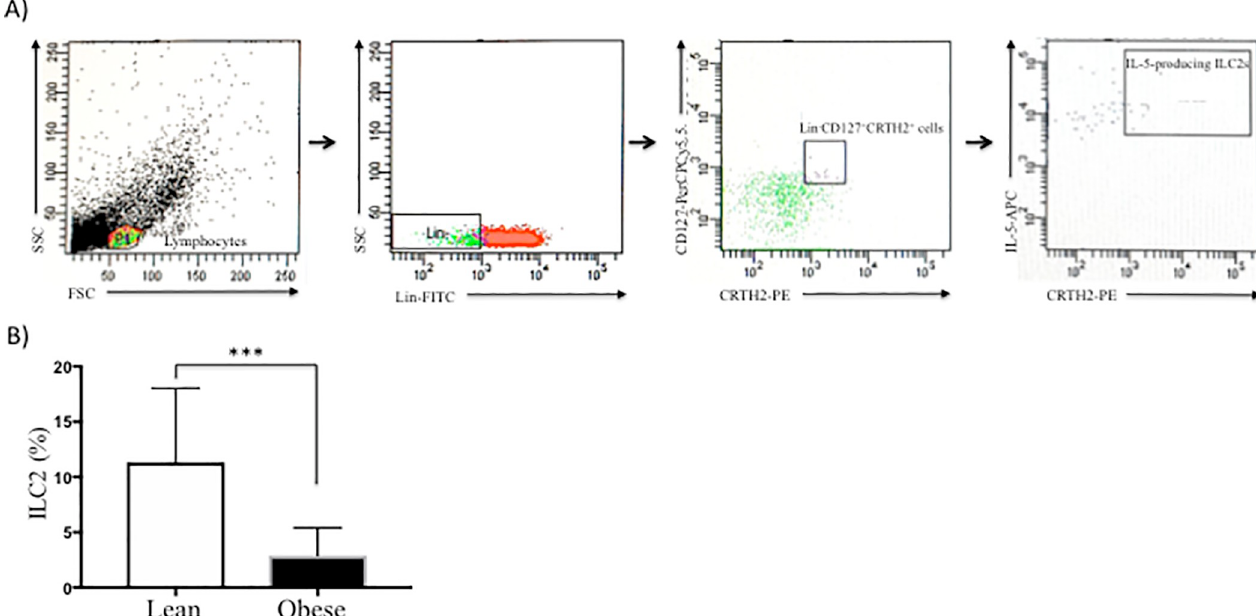
Fig 4. Isolation and characterization of circulating ILC2s in peripheral blood. PBMC were stimulated for intracellular cytokine production with PMA/Io and Golgi inhibitors (Brefeldin A) for 5 h at 37˚C/5% CO 2 , washed and next the cell were surface stained with conjugated antibodies against lineage-FITC, CD127-PerCPCy5.5, and CRTH2-PE. Then fixed, permeabilized and labeled with IL-5 conjugated to APC mAb. Gating strategy to isolate ILC2s population was as follow: we used a lineage cocktail of antibodies to CD2, CD3, CD14, CD16, CD19, CD56, and CD235a to identify T cells, monocytes, neutrophils, B cells, NK cells, mast cells and basophils. Then, we gated Lin - cells, which are negative for these lineage markers, and were further subdivided based on CD127 and CRTH2 expression (third dot plot). Finally, synthesis of IL-5 on Lin - CD127 + CRTH2 + population was gated, and we identified this subpopulation such as ILC2. A) Representative FACS plots of strategy for selection of Lin − CD127 + CRTH2 + IL-5 + cells, called ILC2s from a representative individual with obesity. B) Percentages (mean ± S.D.) of ILC2 from normal-weight subjects (open bars) and individuals with obesity (solid bars) are shown. �� p < 0.01. PMA, phorbol 12-myristate 13-acetate; Io, ionomycin; CD127, interleukin-7 receptor; CRTH2, chemoattractant receptor-homologous molecule expressed on Th2 cells; mAb, monoclonal antibody.